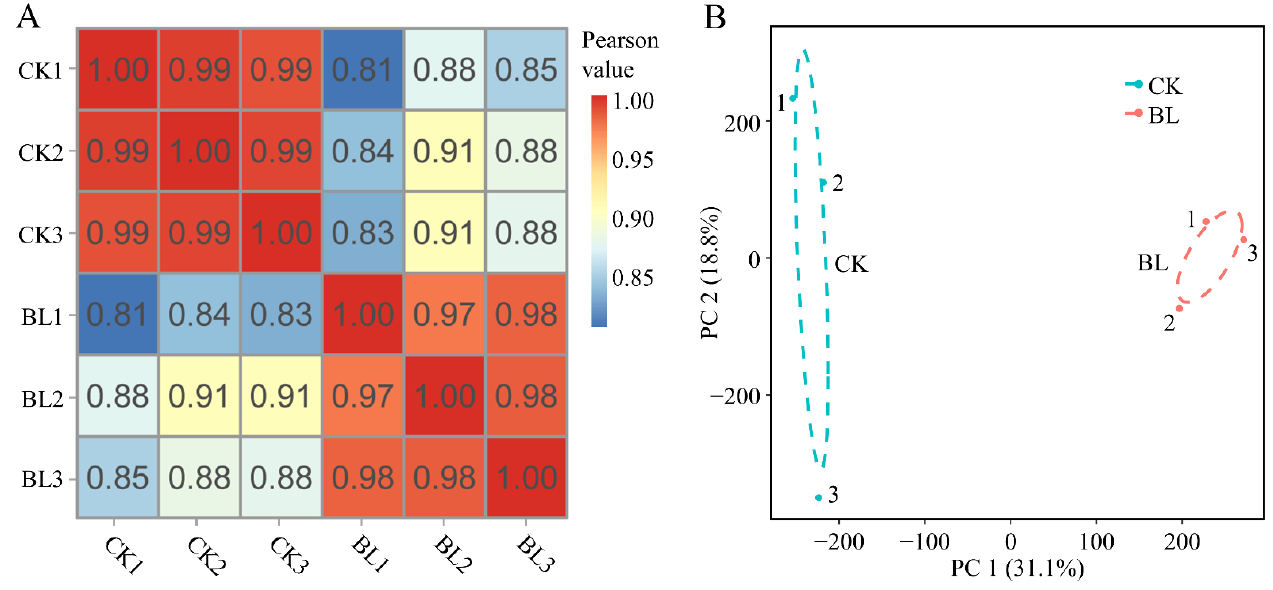
Figure 1. Pearson correlation coefficient analysis and principal component analysis. ( A , B ) The Pear- son correlation coefficient analysis ( A ) and principal component analysis (PCA) ( B ) were performed among six samples of two treatments based on the gene expression data. The PCA diagram shows that CK and BL treatments were separated from each other on PC1.